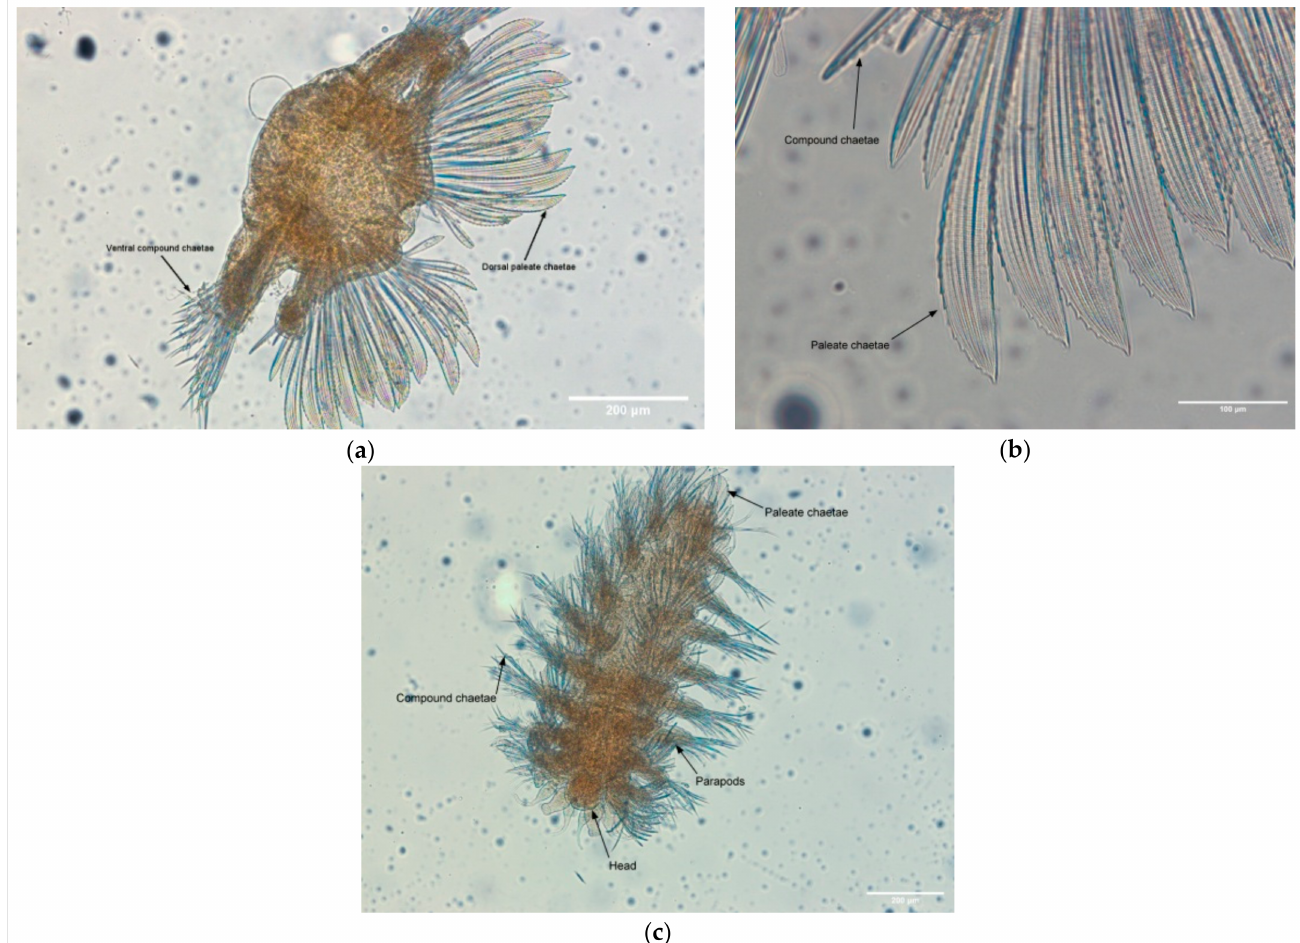
Figure 7. OM images of ( a ) middle body cross-section of a specimen showing the orientation and the type of chaetae ( × 40 magnification), ( b ) detailed view of middle body chaetae ( × 60 magnification), and ( c ) body shape of the specimen ( × 40